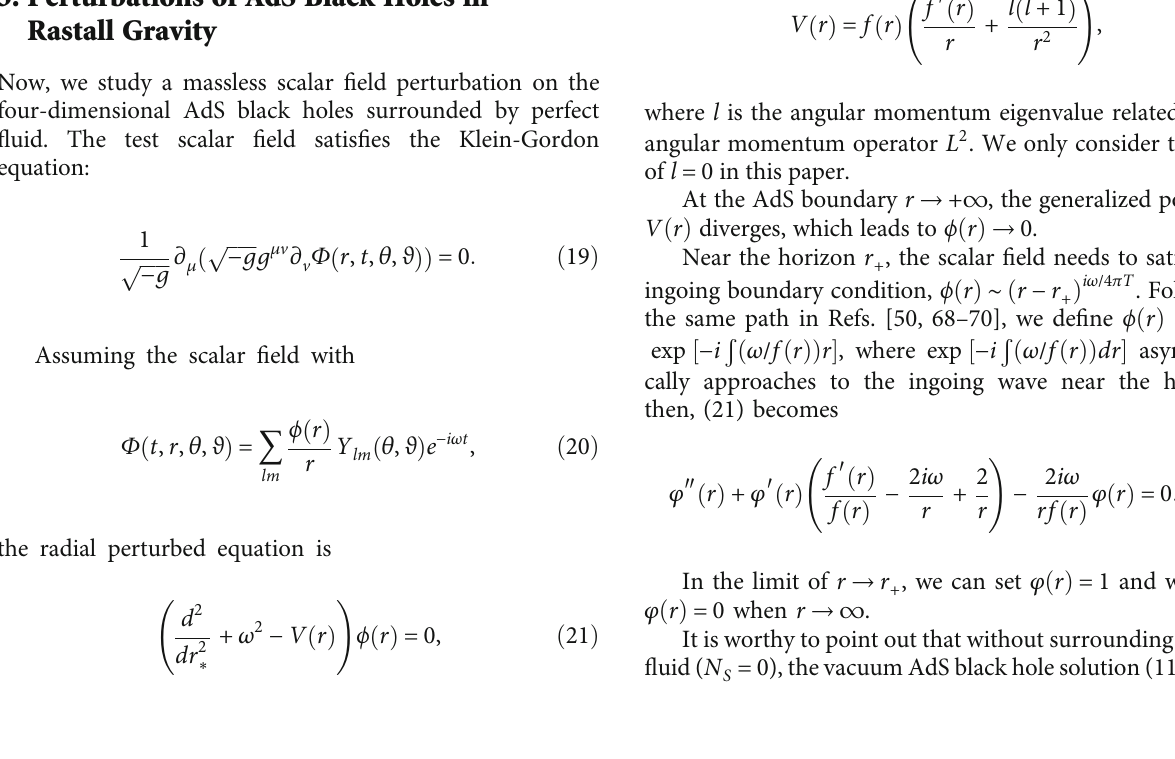
= − 1 , ω = − 2/3 , and P = 0 : 3283 s s